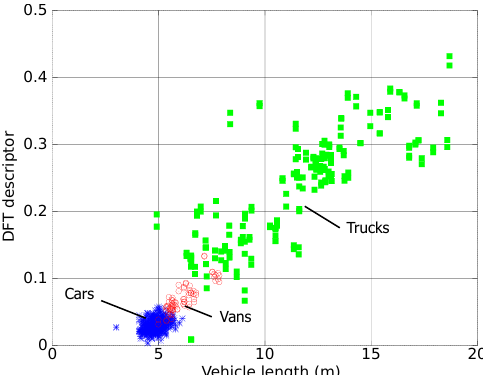
Figure 7. Experimental results: Signature descriptor compute from adquired